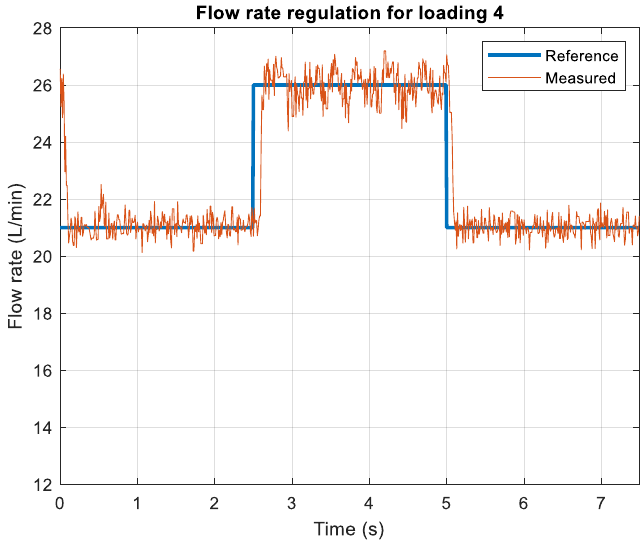
Energies 2022 , 15 , x FOR PEER REVIEW